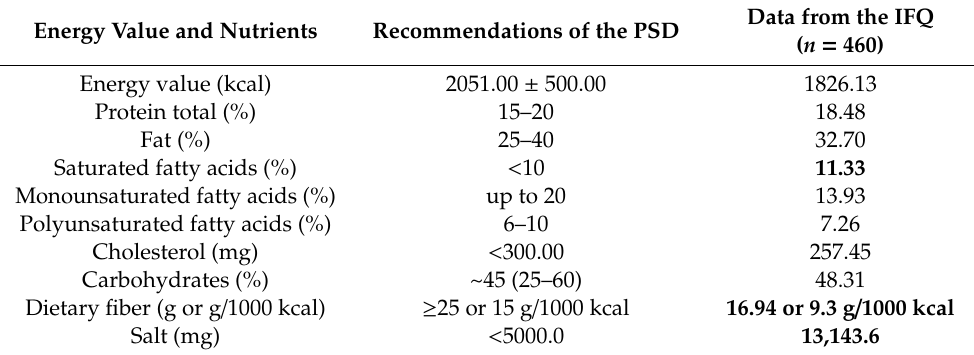
Table 5. The comparison between the 2019 recommendations of the PSD and the data from the IFQ [3]. Energy Value and Nutrients